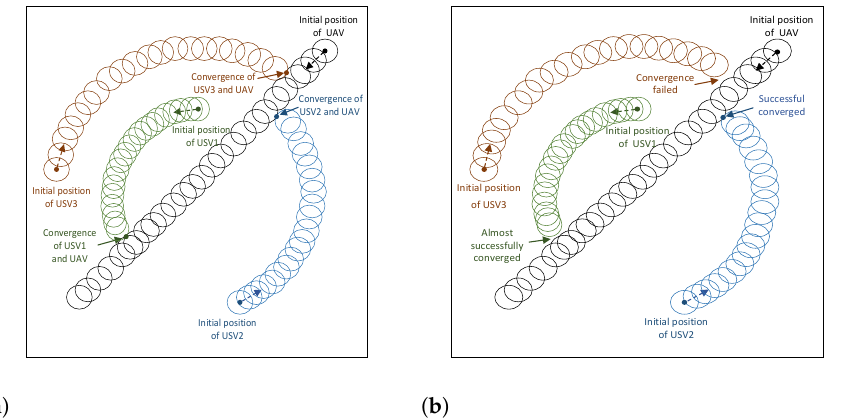
Figure 22. Test of multi-agent coordination effect with or without disturbance. ( a ) is test without noise and ( b ) is test under